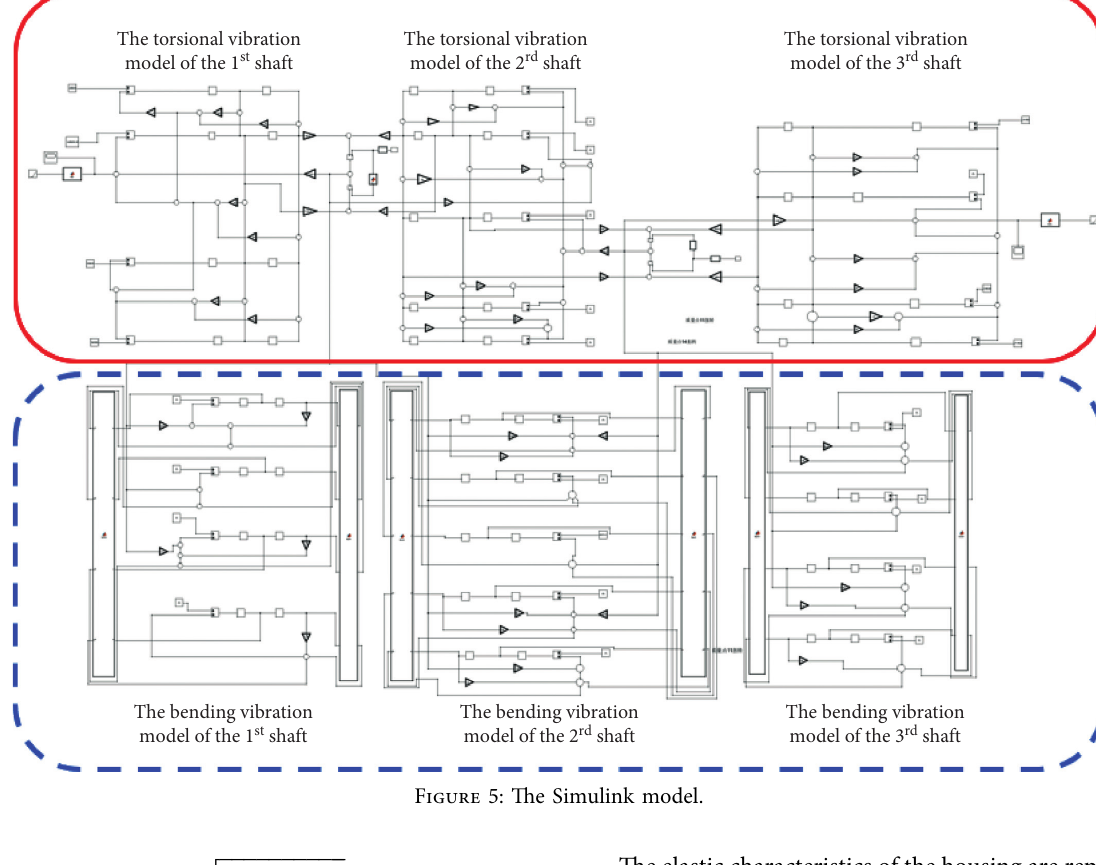
Figure 5: The Simulink